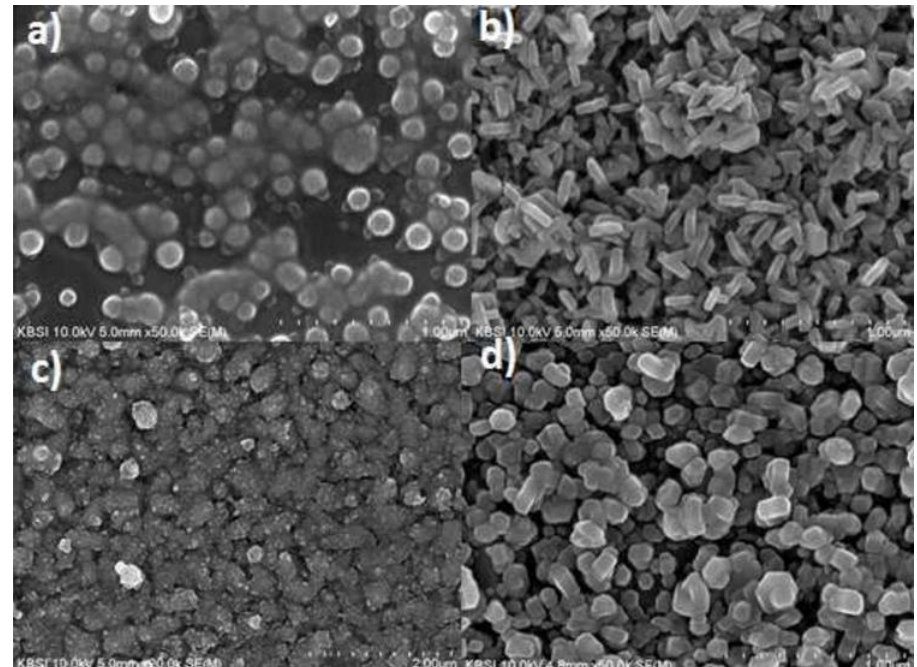
Figure 3. SEM images of NiS thin films deposited with different molar concentrations of thioacetamide. ( a ) Sample A, ( b ) Sample B, deposited with 0.4 M thioacetamide, ( c ) Sample C, ( d ) Sample D deposited with 0.8 M thioacetamide. Reproduced with permission from Reference [22] Elsevier 2015.